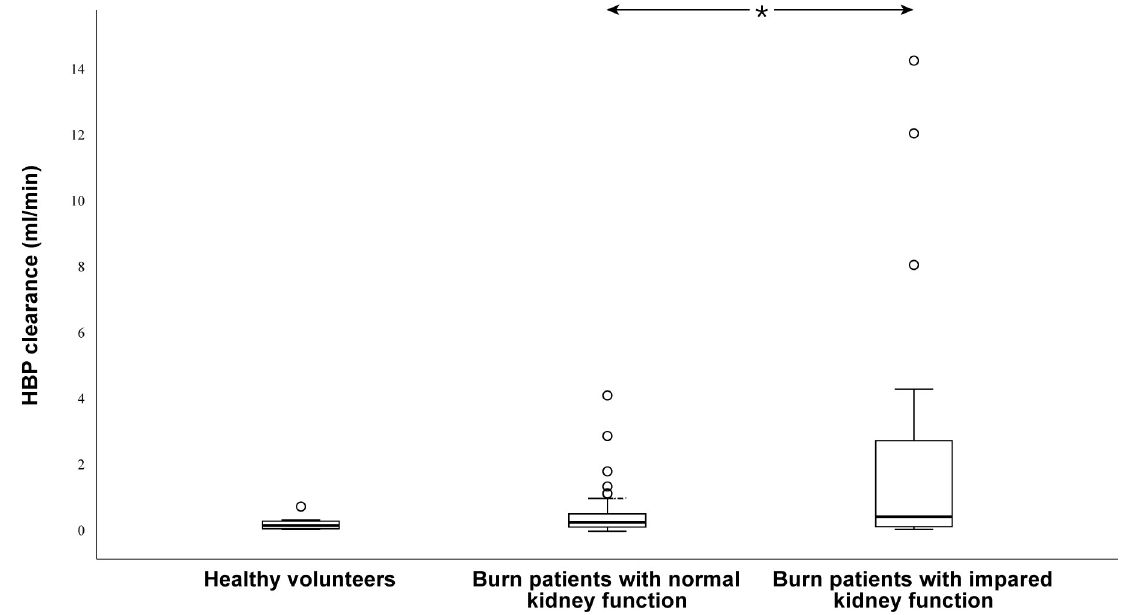
Fig 1. Clearance of heparin binding protein (HBP) in healthy volunteers and burn ICU patients with cystatin C � 1.44 or > 1.44. Boxes indicate the second to third quartile with the median. Brackets indicate min-max values. Circles indicate outliers. � indicates p < 0.05. Clearance was significantly higher in burn ICU patients with cystatin C >